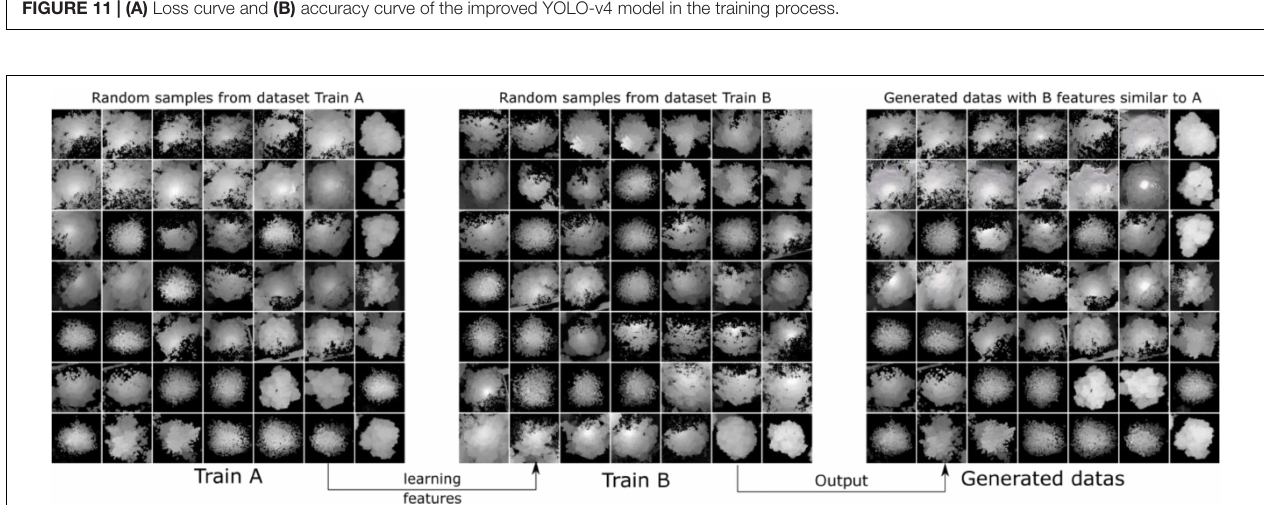
FIGURE 11 | (A) Loss curve and (B) accuracy curve of the improved YOLO-v4 model in the training process.